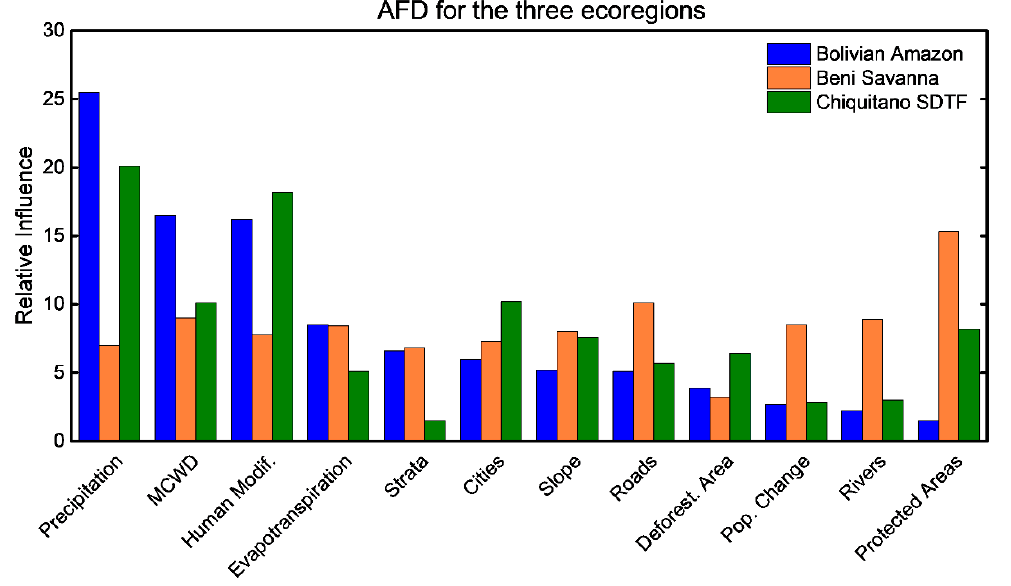
Figure 4. Emerging hotspots ( upper panel ) and Mann–Kendall trend assessments ( lower panel ).